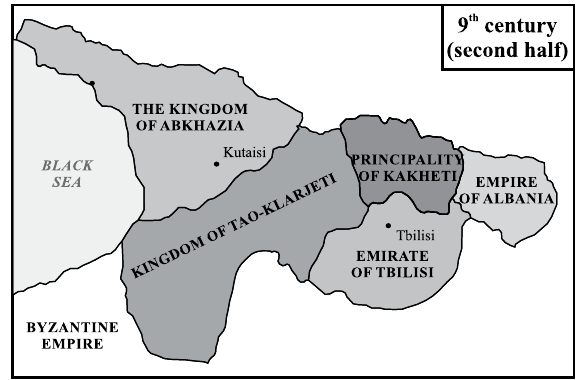
Fig. 2. Stage 2: Attempt at the unification of Georgian territories.